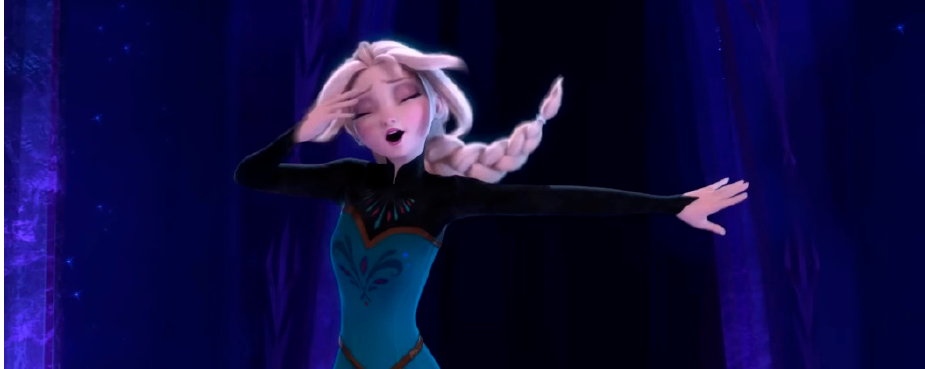
Figure 5. Elsa freeing her hair and letting go her comb (Walt Disney Animation Studios 2013a). The dress surrounds Elsa as an addition, the hair is loosened, yet remains, and the comb is lost.